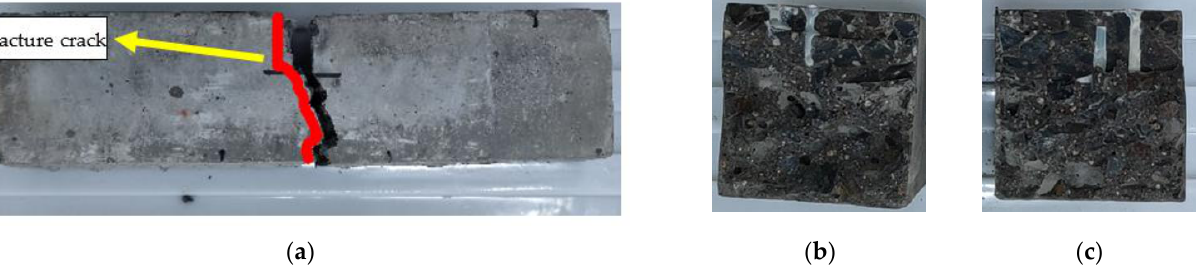
Figure 21. Failure mode of URFND: ( a ) side surface; ( b ) fracture surface 1; and ( c ) fracture surface 2.